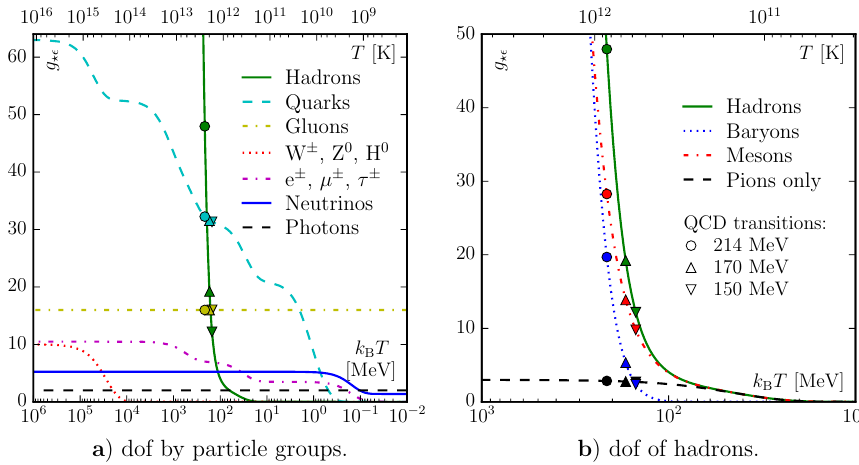
Figure 5. Panel ( a ) shows the contribution to the effective degrees of freedom (dof) for energy density from all particle groups. The drop in each group’s g ⋆ (cid:101) value corresponds to ongoing annihilations of particles at that temperature. Panel ( b ) shows the total hadron contribution (green solid curve) to g ⋆ (cid:101) around the QCD phase transition temperature. We have further divided this into a baryon part (blue dotted curve) and a meson part (red dash-dotted curve). We have also plotted the pions specifically (black dashed curve), as they are the main hadronic contributor to g ⋆ (cid:101) at low temperatures. The two plots clearly show how fast the hadronic contribution increases at temperatures beyond 100 MeV. In both panels, we have marked the contribution to g ⋆ (cid:101) from hadrons, baryons, and mesons, at the three transition values of 214 MeV ( ◯ symbols), 170 MeV ( △ symbols), and 150 MeV ( ▽ symbols),